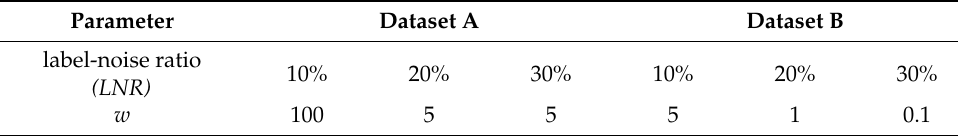
Table 3. Parameter values of the MPEGMM.